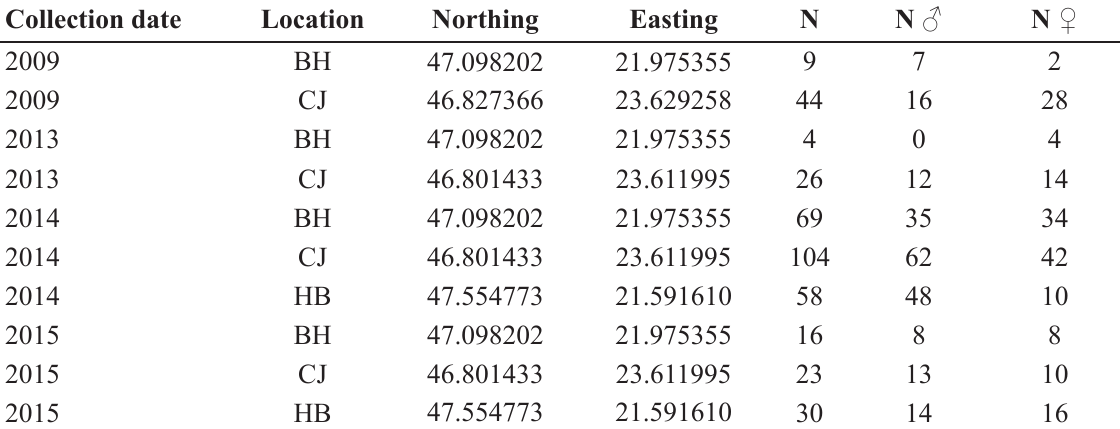
Table 1. Collection dates, location and number of M. robiniae Lakatos & László sp. nov. individuals. Abbreviations: BH = Bihor County, Romania; CJ = Cluj County, Romania; HB = Hajdú-Bihar County,